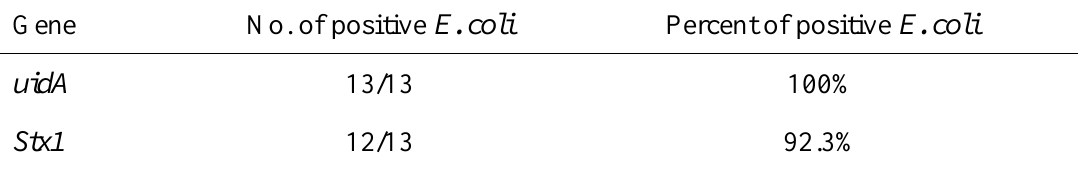
Table 3: The variation rate of the uidA, Stx1 , and Stx2 genes in E. coli O157:H7 isolates. Gene No. of positive E. coli